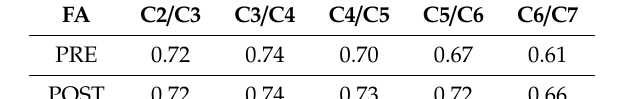
Table 2. Fractional anisotropy (FA) values of the anatomical level.